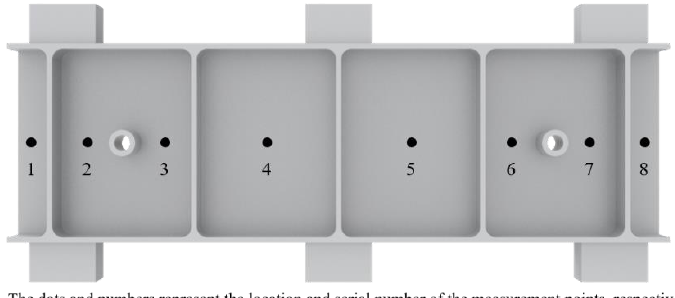
11 of 13 Figure 11. Experiment and measurement: ( a ) milling operation; ( b ) measuring deformation. 5.2. Discussion of Experimental Results Figure 12 shows the positions of the eight deformation monitoring points, and Figure 13 shows the deformation monitoring values of the eight measuring points before and after applying the clamping action control strategy. Among them, the No. 2 workpiece